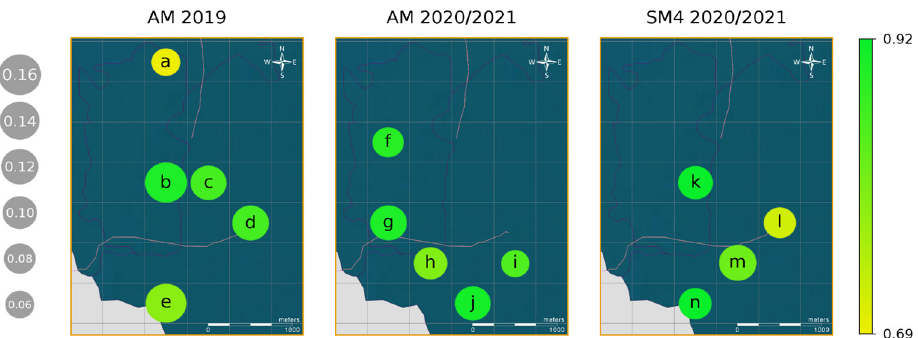
Figure 2. Average occurrence of songs and average recall obtained from 10 iterations of cross-validation, shown for the different recording locations of the three datasets: AM 2019, AM 2020/2021, and SM4 2020/2021. The colour gradient indicates the recall (correctly classified positive cases divided by the total number of positive cases), while the circles’ sizes represent the occurrence (positive cases divided by the total number of the cases). The recording locations shown are those with averages of more than 250 recordings ( ≈ 40 h) present in the test set; their exact coordinates and their values of recall and song occurrence are shown in Table S1. Table 1. Accuracy, precision, recall, and F1 score values were obtained for the test sets of the three sets of data (AM 2019; AM 2020/2021; and SM4 2020/2021); we obtained the uncertainty associated with the different measures through a 10-fold cross-validation. This procedure was performed alongside the transfer learning for the two 2020/2021 test sets. We also report the variation in the metrics before and after data augmentation and/or transfer learning. Specifically, we measured the metric values of AM 2019 before and after data augmentation; for both AM and SM 2020/21 we measured the metric values before and after transfer learning with or without data augmentation. TL: transfer learning; DA: data augmentation. AM 2019 Test Set